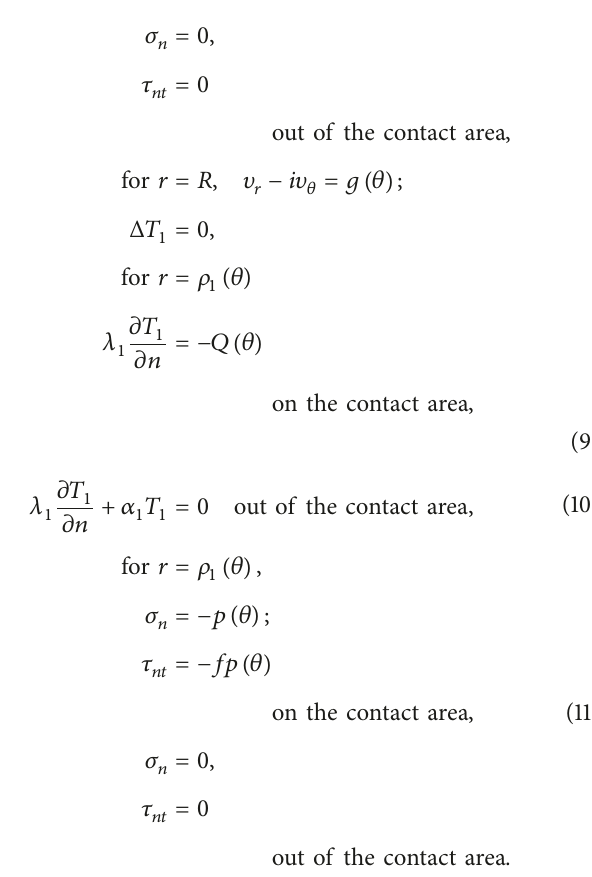
Figure 3: Design diagram of contact problem for